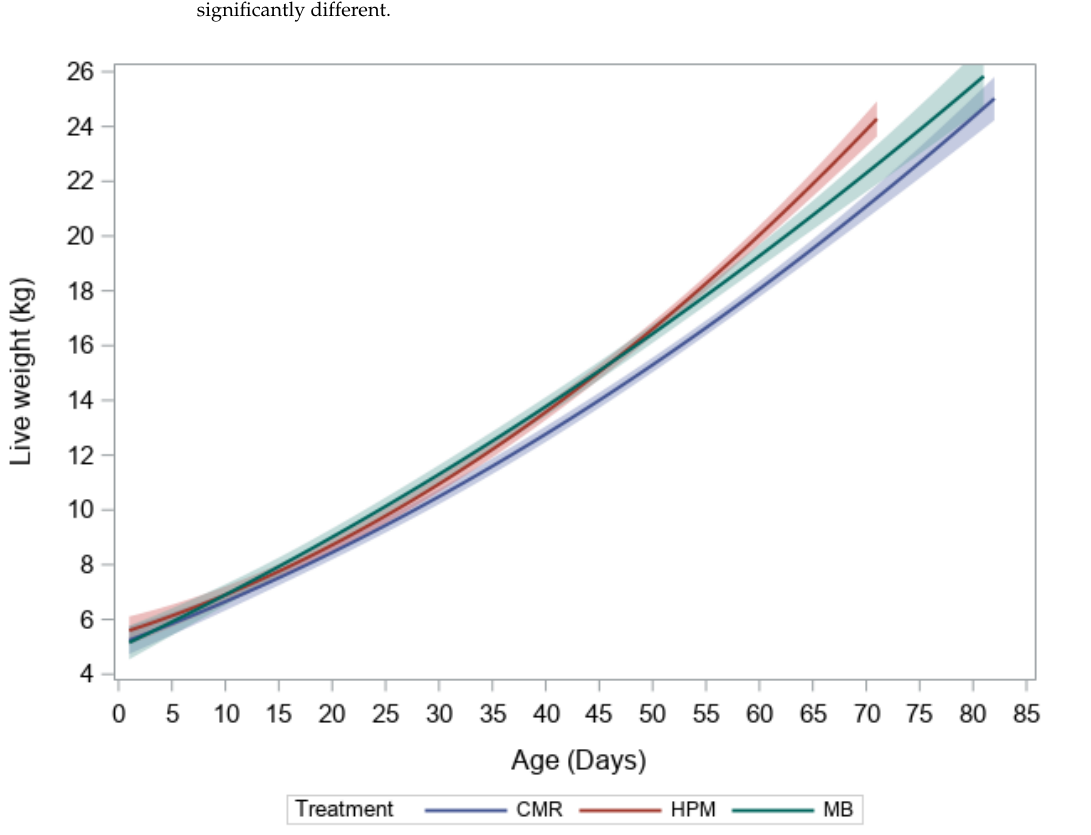
diet ( p ≤ 0.05, Table 2). There was no significant effect of diet on measures of bone area/circumference and muscle area surrounding the